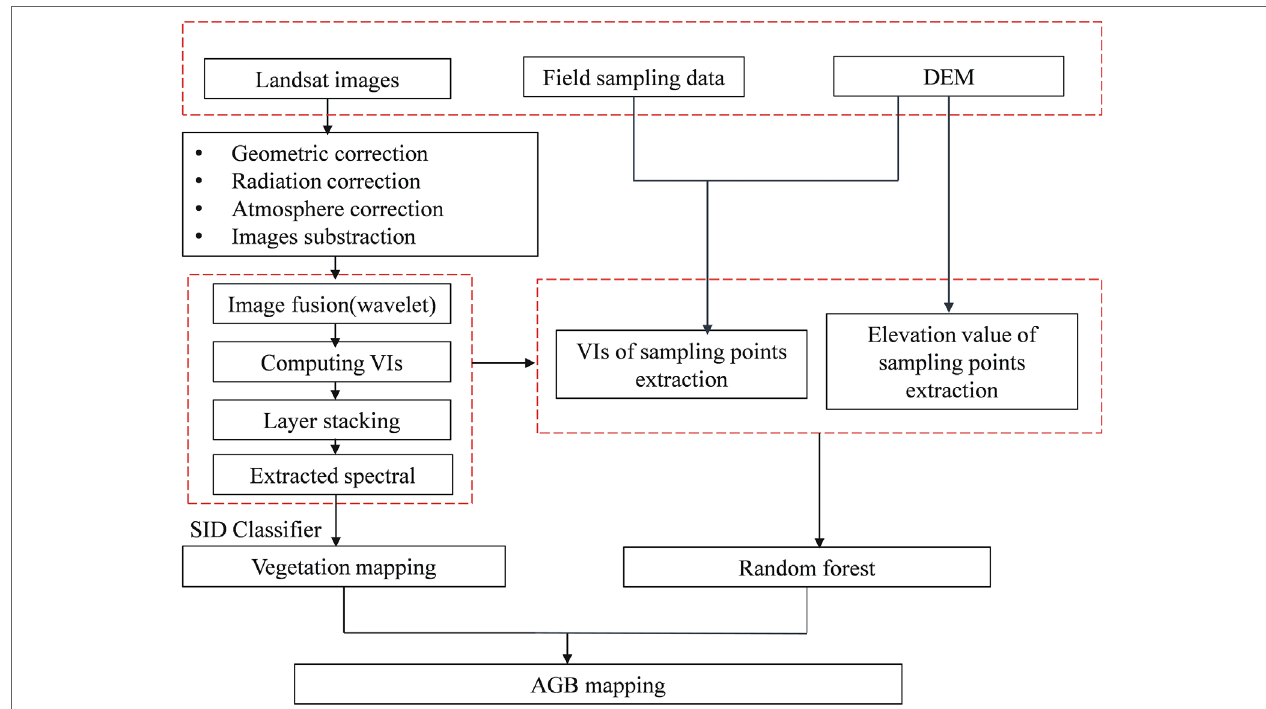
FIGURE 3 | Flowchart used to map AGB in Poyang Lake using Landsat